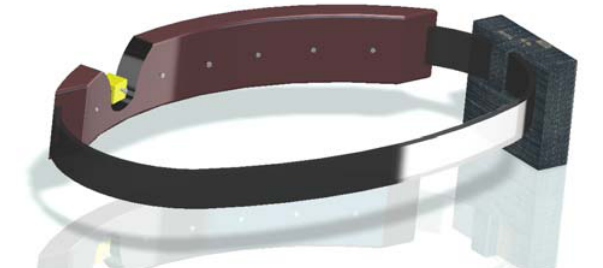
Figure 19. Representation of the tactile belt with seven miniature actuators and the control